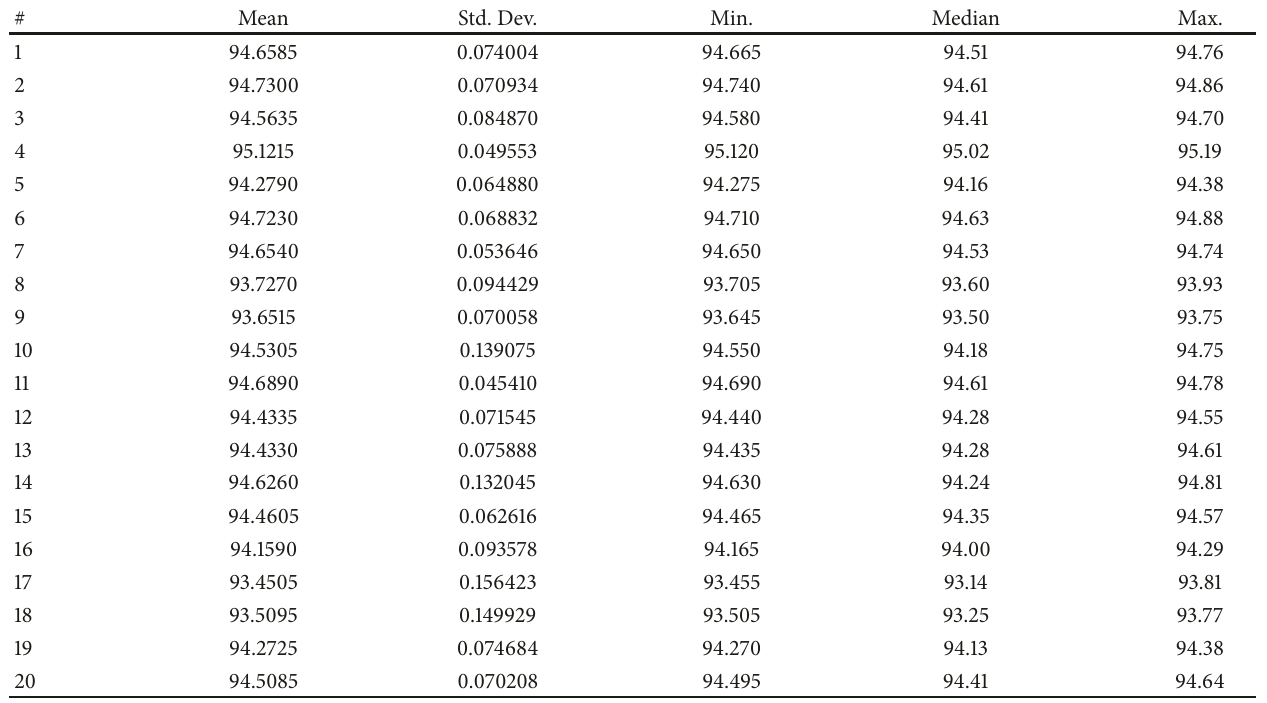
Table 4: Summary of accuracies of the best 20 GE individuals after full training in EMNIST Letters.